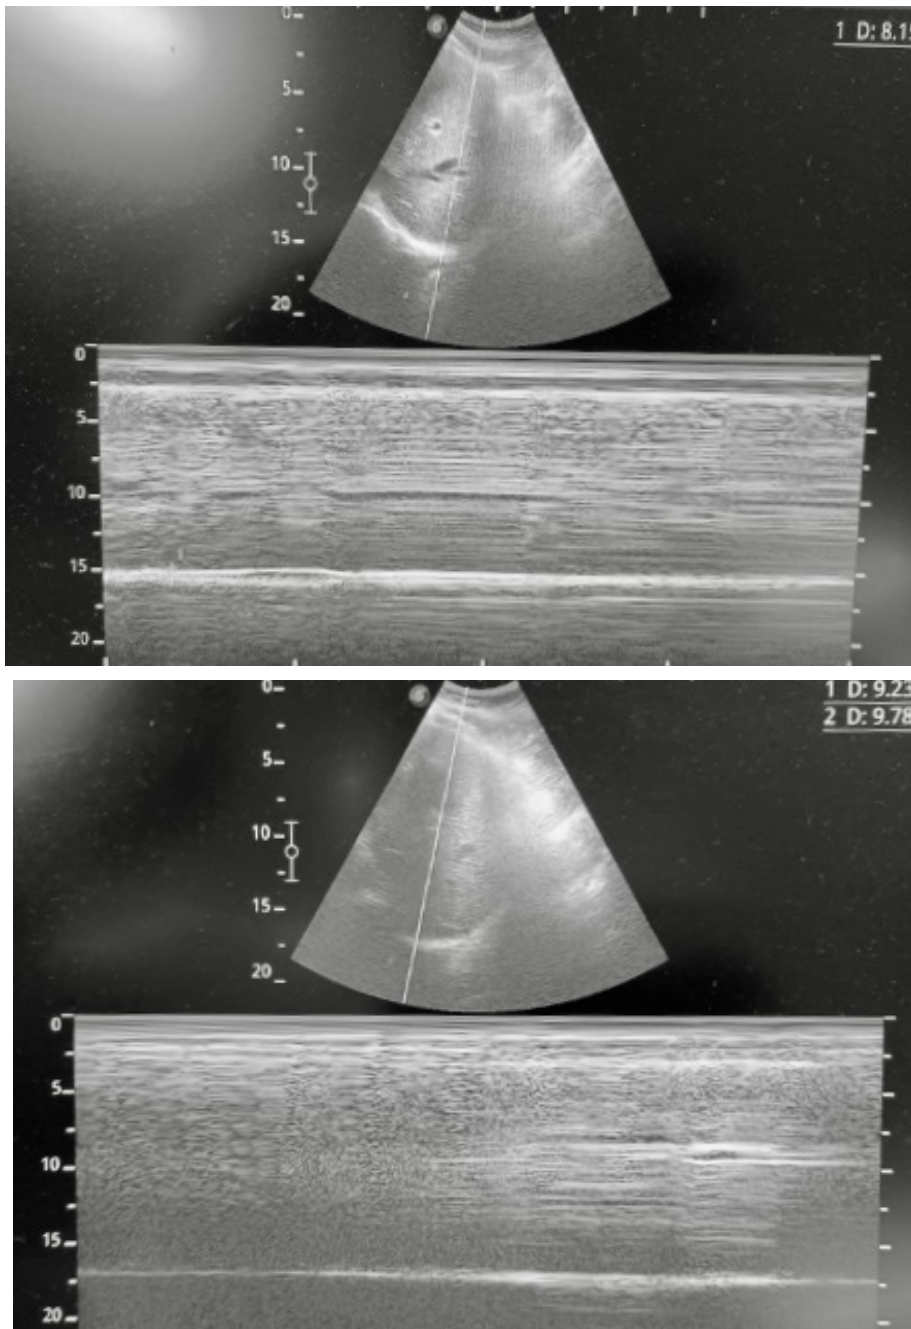
Figure 3 . Ultrasound evaluation of B.M.’s right hemidiaphragm during resting breathing; upper image, end-exhalation, lower image, end-inhalation. B-mode and M-mode were used for the evaluation of the diaphragm excursion: it can be easily noted that there were no diaphragm movements during resting breathing.